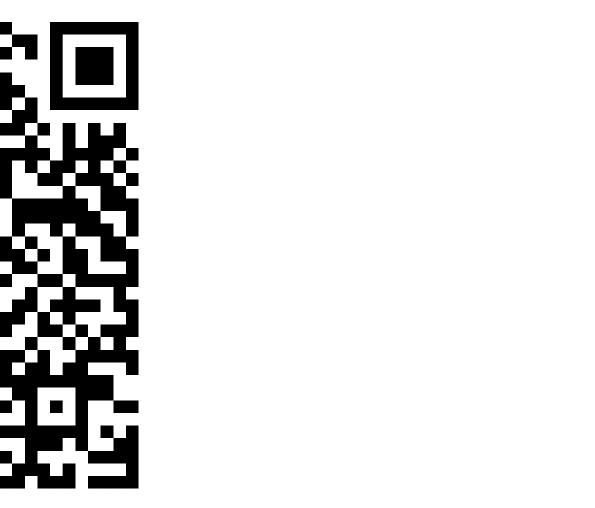
Figure 16. QR code where it can be downloaded: 3D22 MX Image Database, 3D22 MX Toolbox and obtained